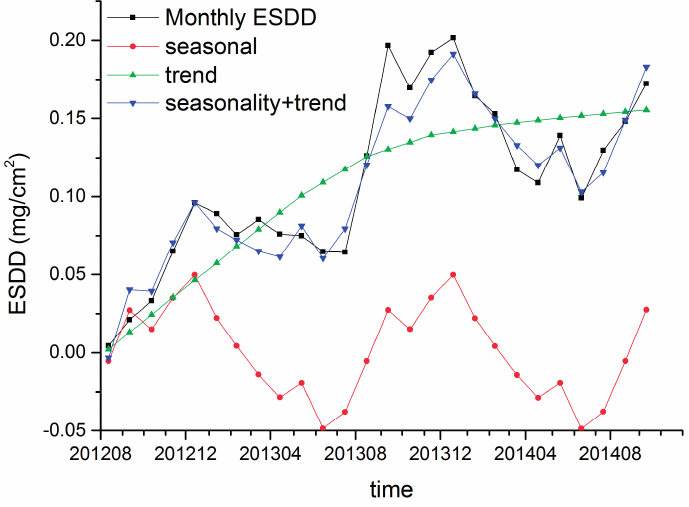
Figure 12. Decomposition results of Huangshi sites.